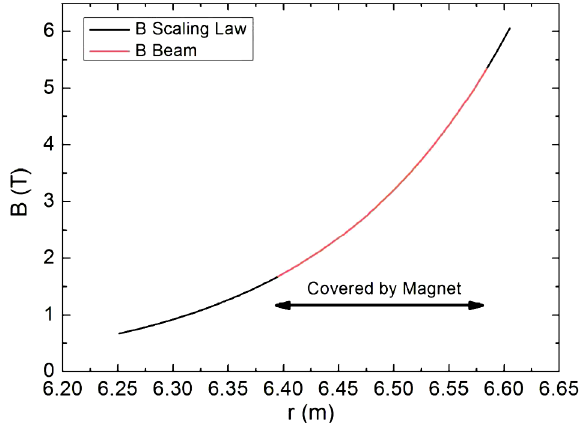
FIG. 18. Vertical magnetic field of the carbon F magnet, com- paring the ideal scaling law with the real magnetic field. For tune stabilization (see text) the quadrupole component was increased by 4.5% and the sextupole component by 2%. The octupole and decapole components were decreased by 4% and 25%, respec-